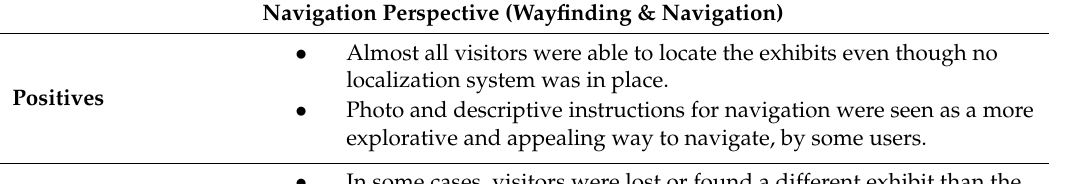
Table 5. Insights from findings on the navigation perspective, and implications for